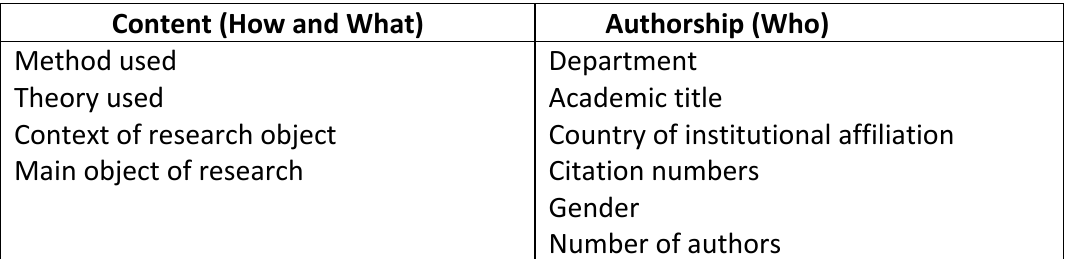
Table 1. The bibliometric analysis divided up by content and authorship Content (How and